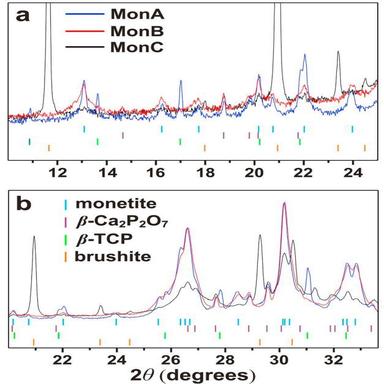
Powder diffractograms collected from the MonA, MonB, and MonC cements and displayed over 2θ ranges of (a) 10∘ –25∘ and (b) 20∘ –34∘ . The Bragg peaks were assigned to the following four phases, identified in the legend in (b): monetite (ICSD No 917), β-Ca2P2O7 (ICSD 14313), β-TCP (ICSD 97500; only present in MonA), and brushite (ICSD 16132; only in MonC).